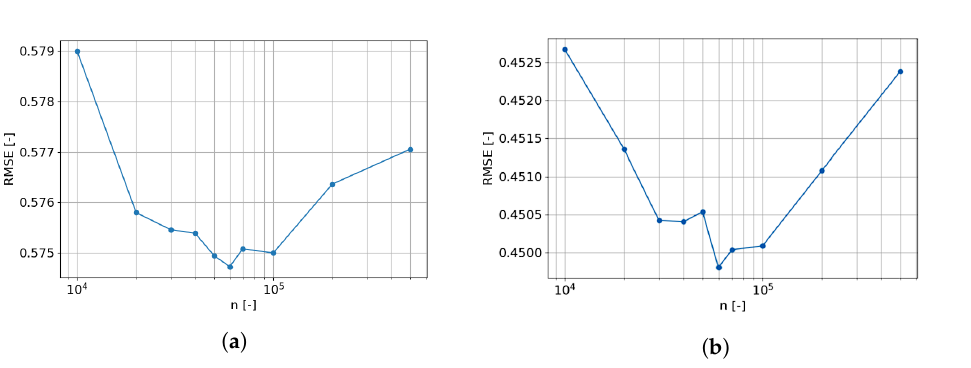
Figure 5. Learning curve. ( a ) Farm A. ( b ) Farm B.